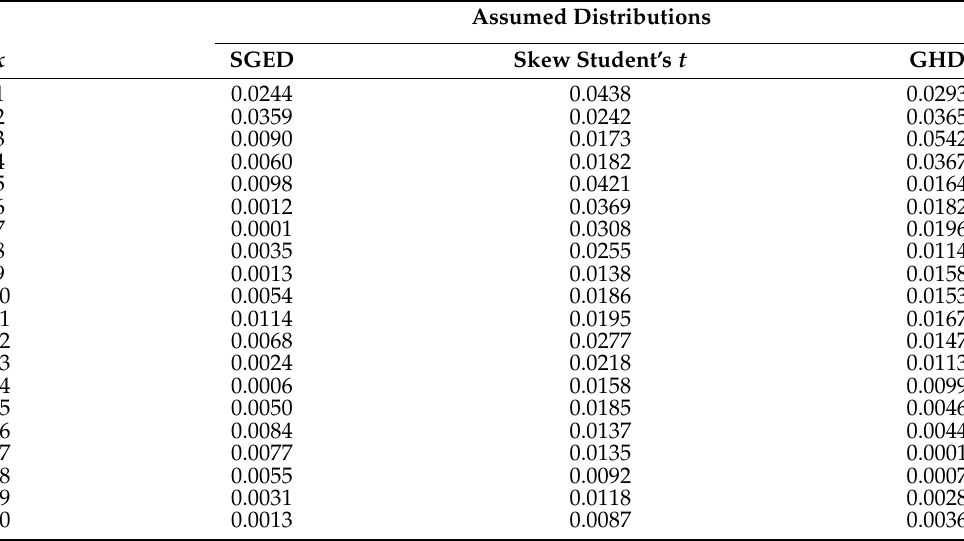
Table 4. Kullback–Leibler distance for the empirical distributions of standardized residuals when comparing to SGED, skew Student’s t distribution, and